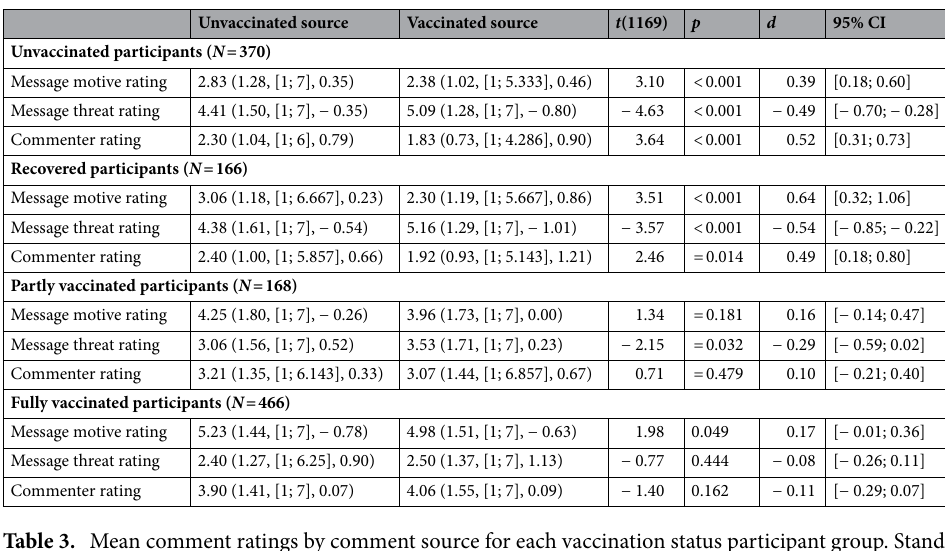
Table 3. Mean comment ratings by comment source for each vaccination status participant group. Standard deviations, ranges, and skew are in parentheses. Reporting adjusted estimates for Cohen’s d.